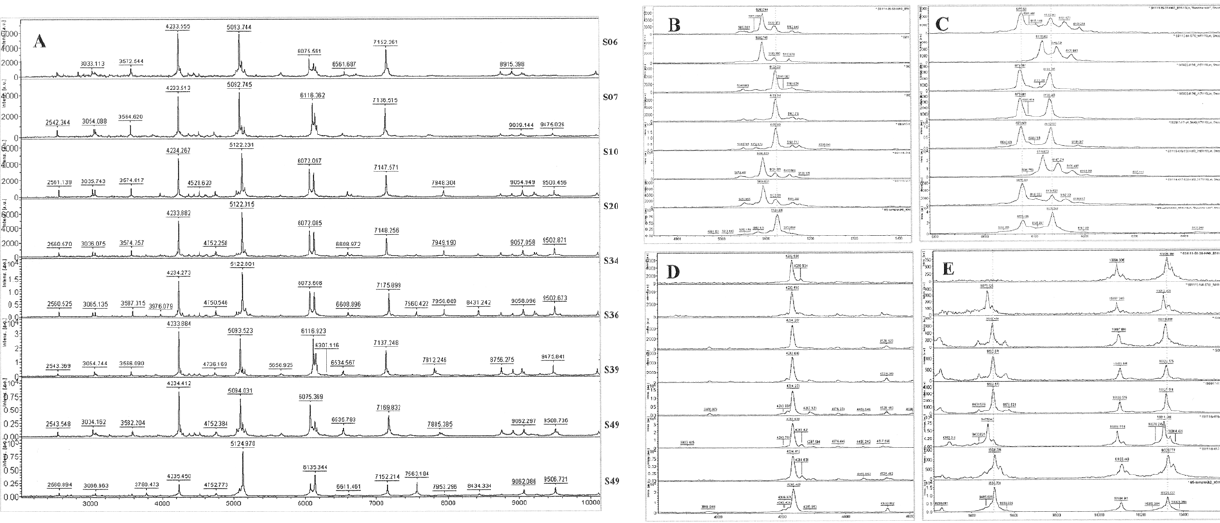
Figure 6. MALDI-TOF mass spectra from Pseudoalteromonas(PAL) isolates. The mass spectrum of P. tetraodonis was added to the database after identification of an isolate by 16S rRNA gene sequencing. Isolate S49, with some similarities to the mass spectral pattern of PAL is also included in the comparisons. Panel A shows spectra of all PAL isolates for the range of m/z 3000–10000. Panels B to E show similarities and differences between the PAL isolates at different m/z . The order of isolates in all panels is as labelled in panel